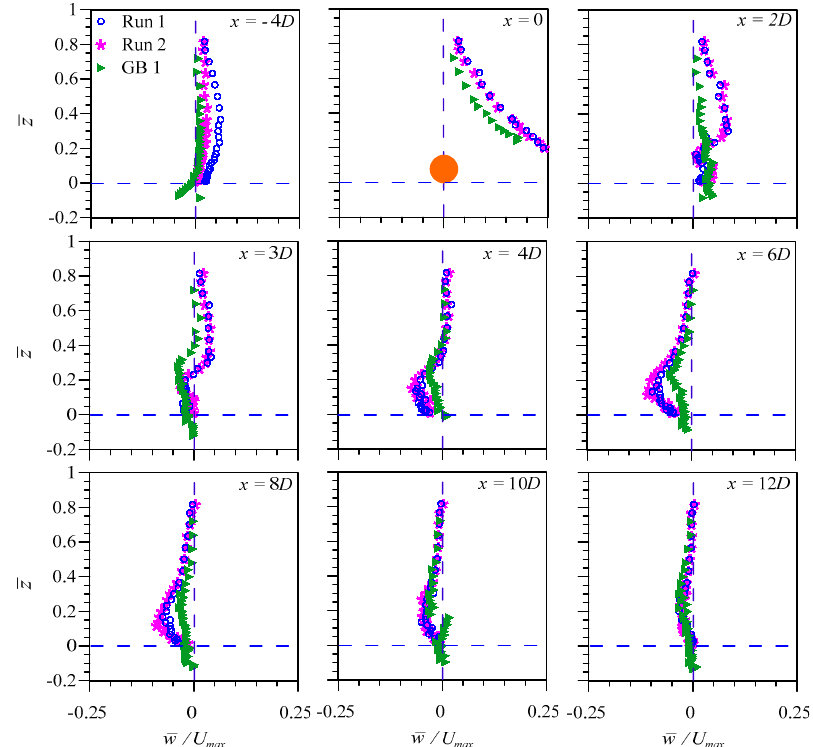
Figure 7. The variation of normalized time-averaged vertical velocity ( w / U max ) against normalized vertical distance ( z ) at different measuring stations ( x ) for Run 1, Run 2, and GB 1.